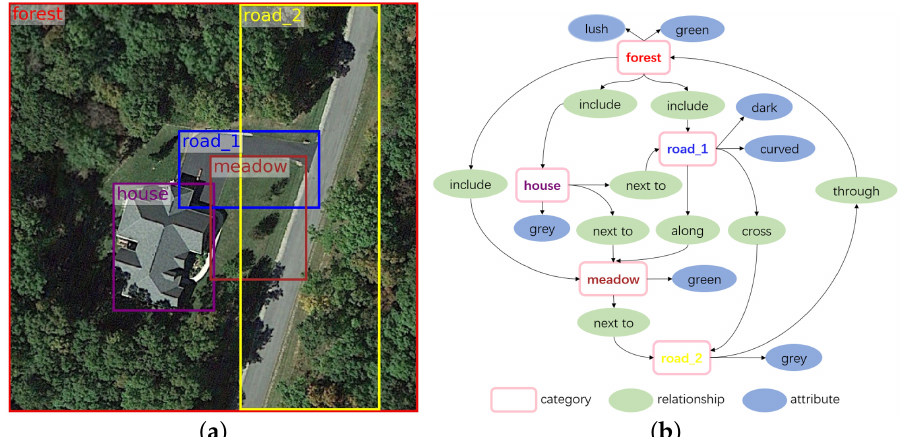
Figure 10. Visualization results on RSSGD. ( a ) is the visualization result of object detection. ( b ) is the visualization result of scene